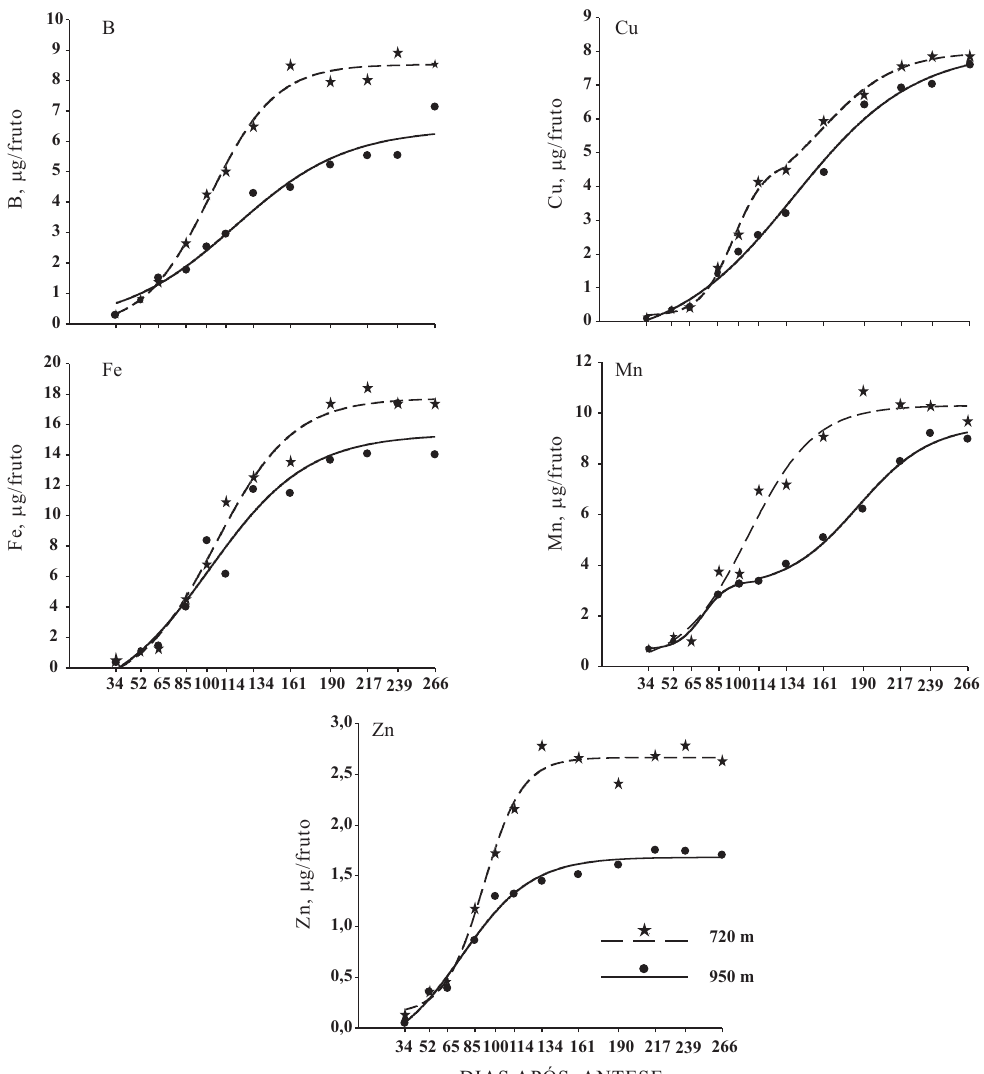
Figura 1. Acúmulo de boro, cobre, ferro, manganês e zinco em frutos de cafeeiro em função do tempo decorrido após a antese, em duas